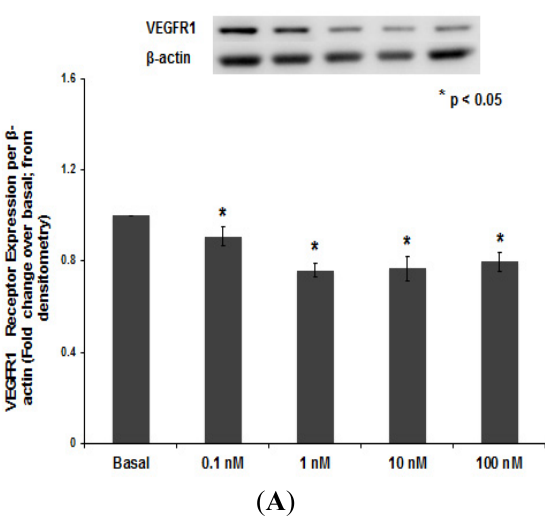
( A ) VEGFR1, ( B ) AT receptor, and ( C ) AT receptors expression were measured in the 1 2 cell lysates by western Blot. PNTTU significantly ( * p < 0.05)